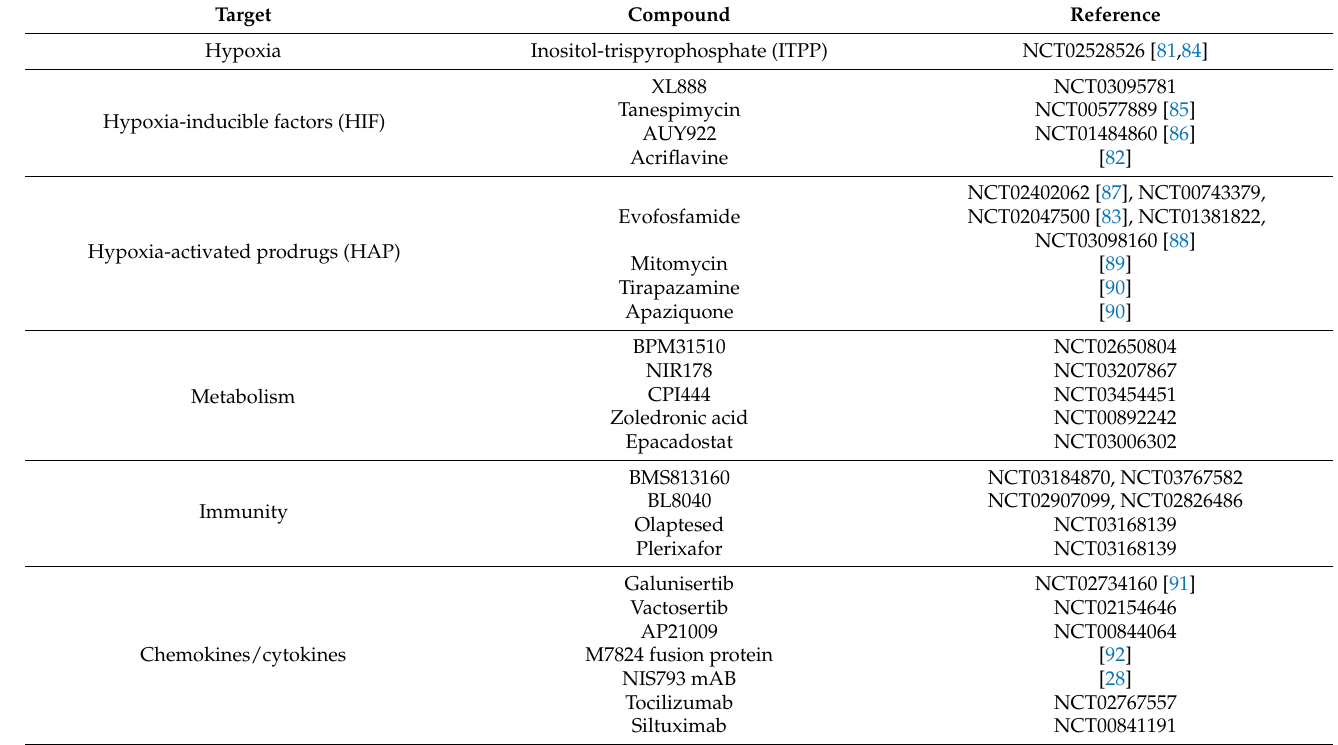
Table 1. Pharmaceutical targeting of hypoxia in